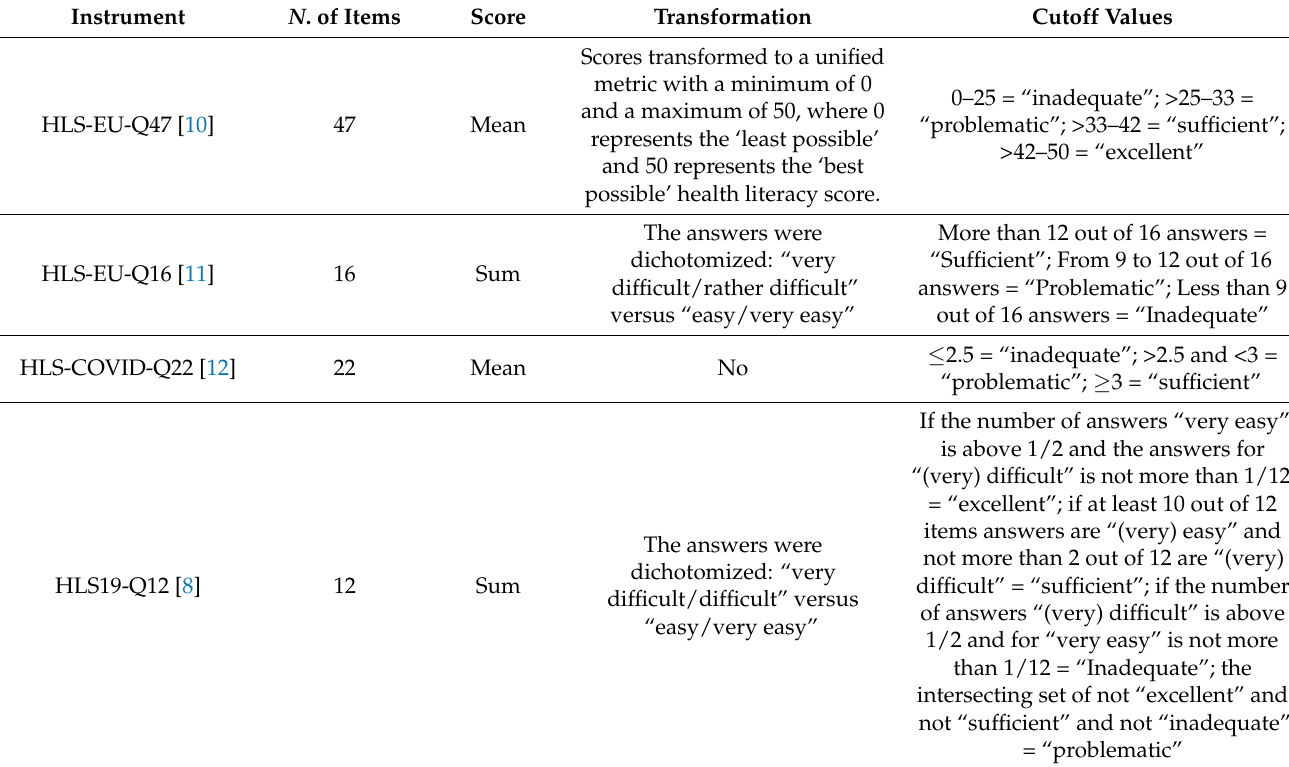
Table 1. Health literacy instruments, scores, and cutoff